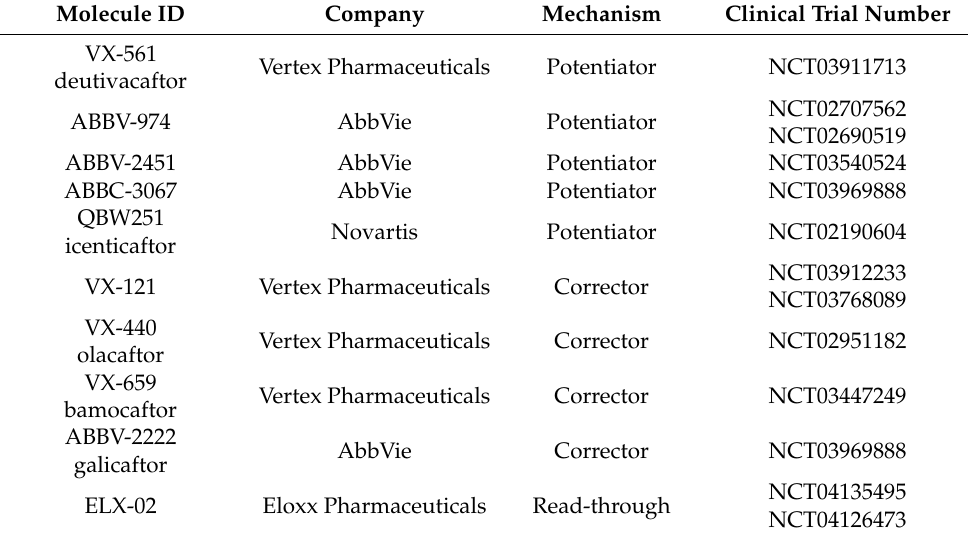
Table 2. CFTR modulators other than those in current clinical